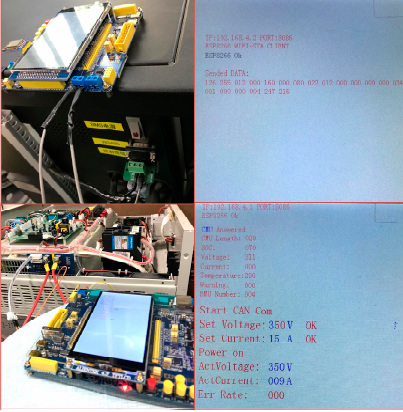
Figure 8. Experimental platform of wireless data transmission.